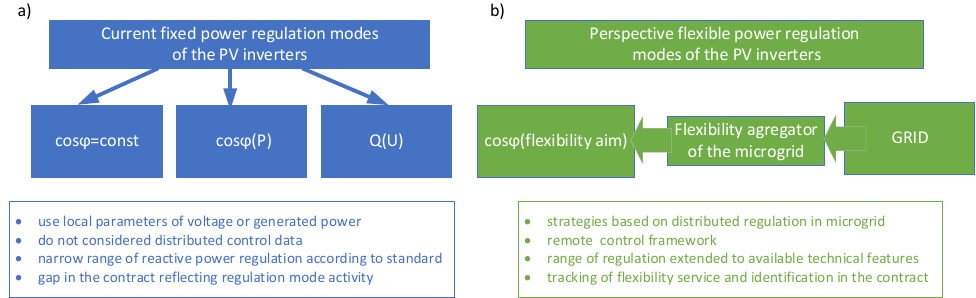
Figure 6. Current ( a ) and prospective ( b ) methods for managing inverter control resources for flex ‐ ibility purposes.